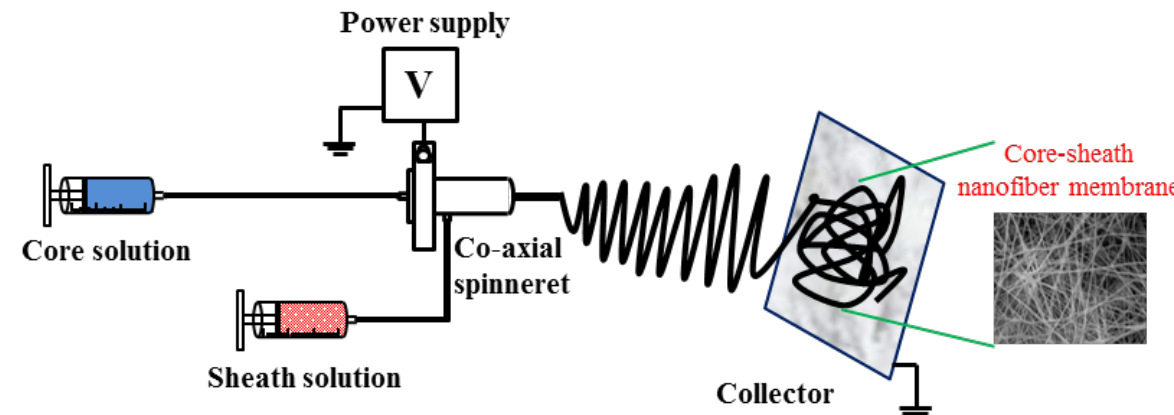
Scheme 1. The schematic diagram for preparation of core-sheath nanofiber membranes (CSNFMs). The sheath spinning solution contains polylactic acid in methylene chloride/N,N’-dimethylformamide. For silver nanoparticles (Ag NPs)-embedded CSNFMs, the sheath spinning solution contains AgNO 3 , which is exposed to UV light beforehand to form Ag NPs. The core spinning solution contains hyaluronic acid and polyethylene oxide in formic acid.